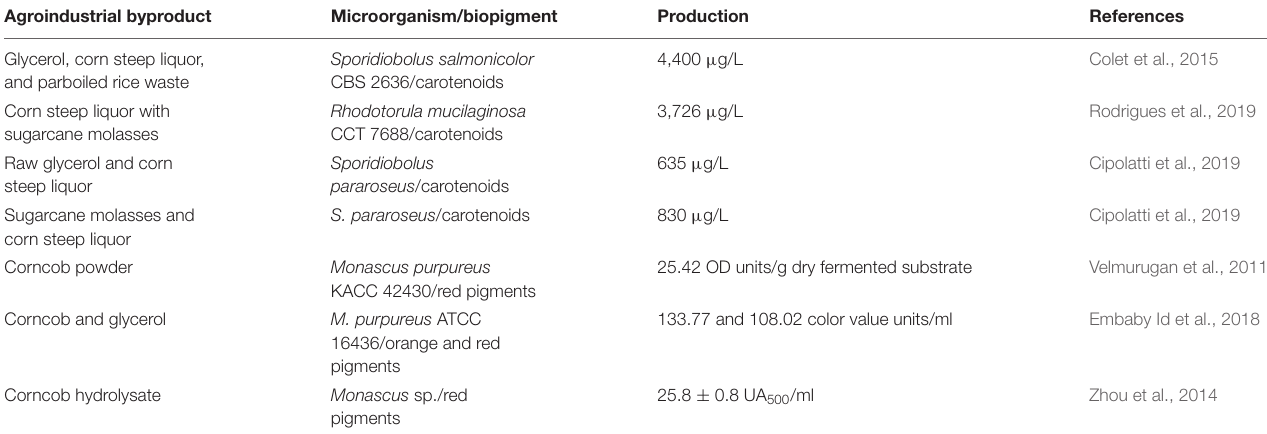
TABLE 4 | Biopigment production using different corn